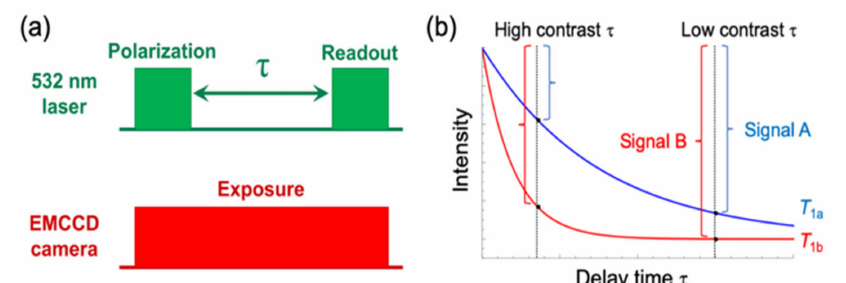
Figure 1. ( a ) Pulse sequence of T 1 measurement. The first laser pulse (“Polarization”) polarizes the spin configuration of nitrogen-vacancy (NV) centres into m s = 0. During the interval time τ , the spins relax into m s = ± 1. Note that the “Readout” fluorescence intensity of NV centres in the state of m s = 0 is stronger than m s = ± 1. Therefore, the fluorescence decreases in accordance to the relaxation asshown in ( b ). ( b ) Schematic plots of T 1 relaxation of the fluorescence intensity. Di ff erent two cases (T 1 = T 1a and T 1b ) were shown. A signal at τ was defined as di ff erence between fluorescence intensities at the interval time = 0 and τ . To obtain T 1 -weighted images, pixel signals are mapped with false colour. The magnitude of the contrast defined as signal B—signal A have dependence on τ